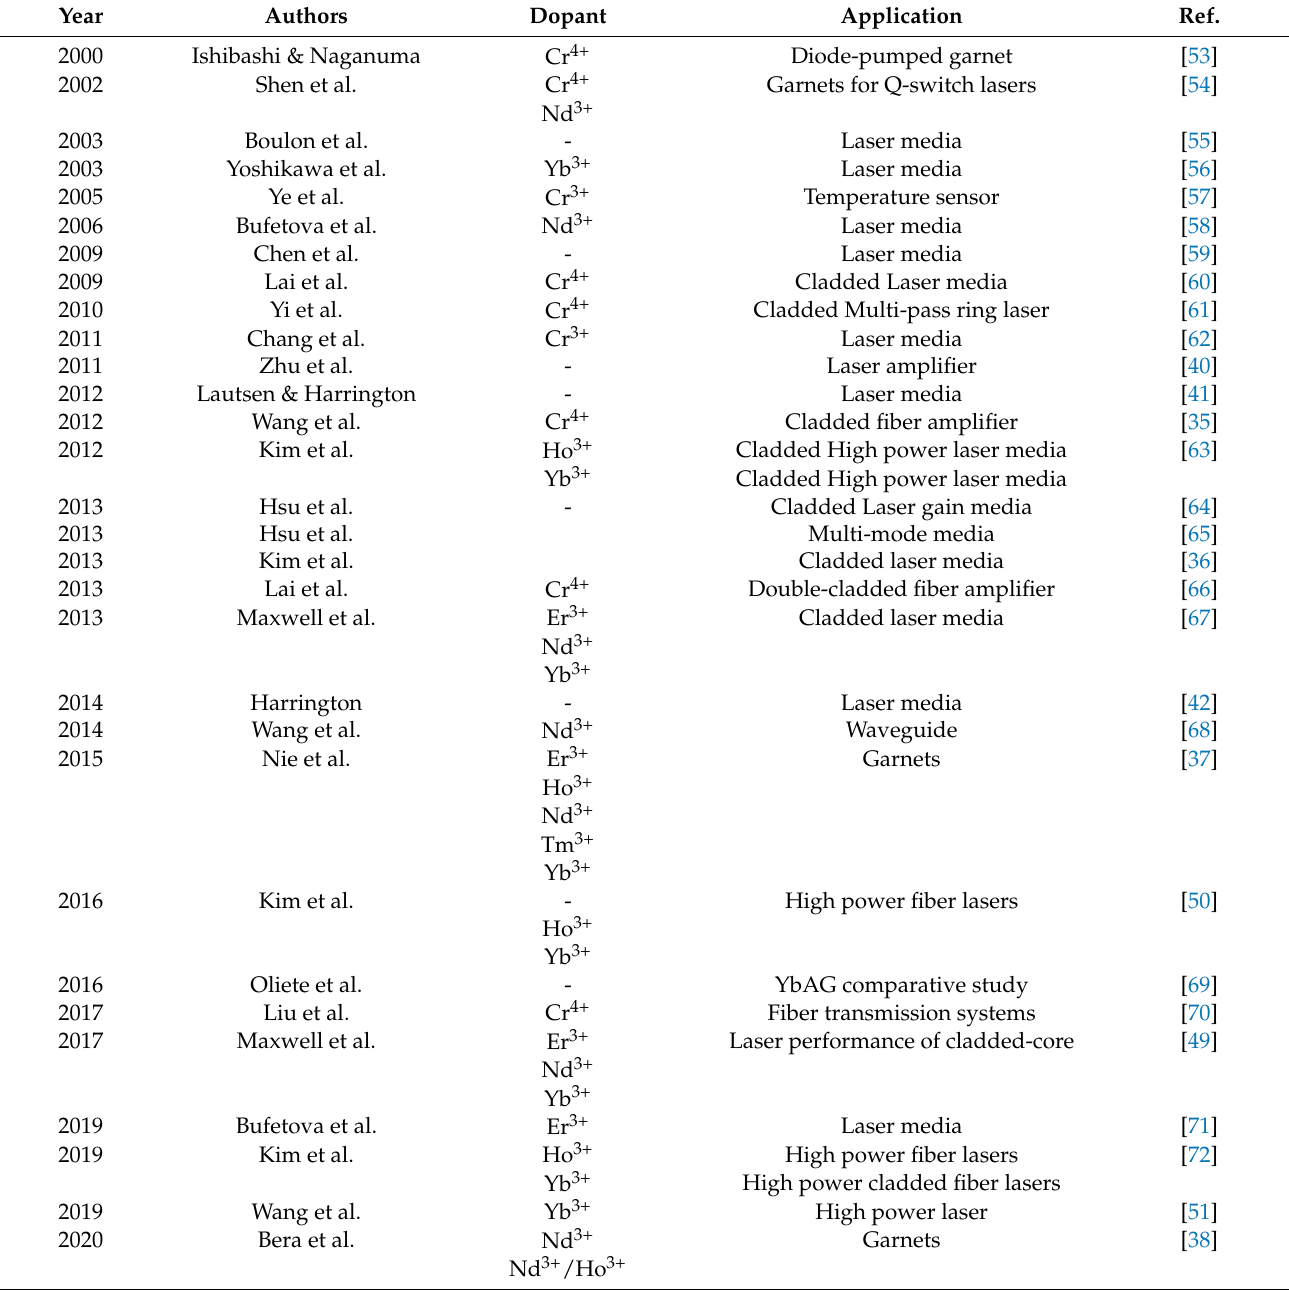
Table 1. Y 3 Al 5 O 12 (YAG) garnets grown by LFZ since the review by Rudolph and Fukuda in 1999 [8].